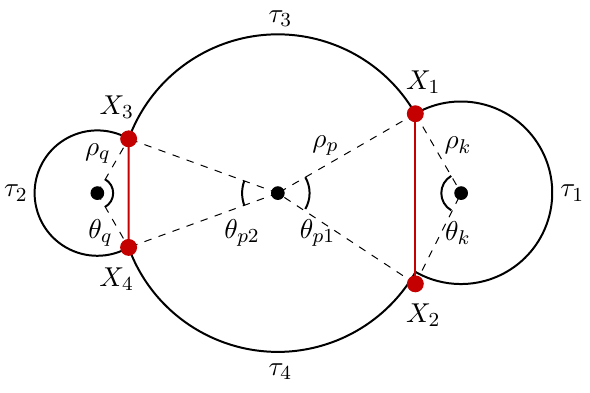
Figure 6 . The boundary curve that maximizes the Schwarzian action with two pairwise operator